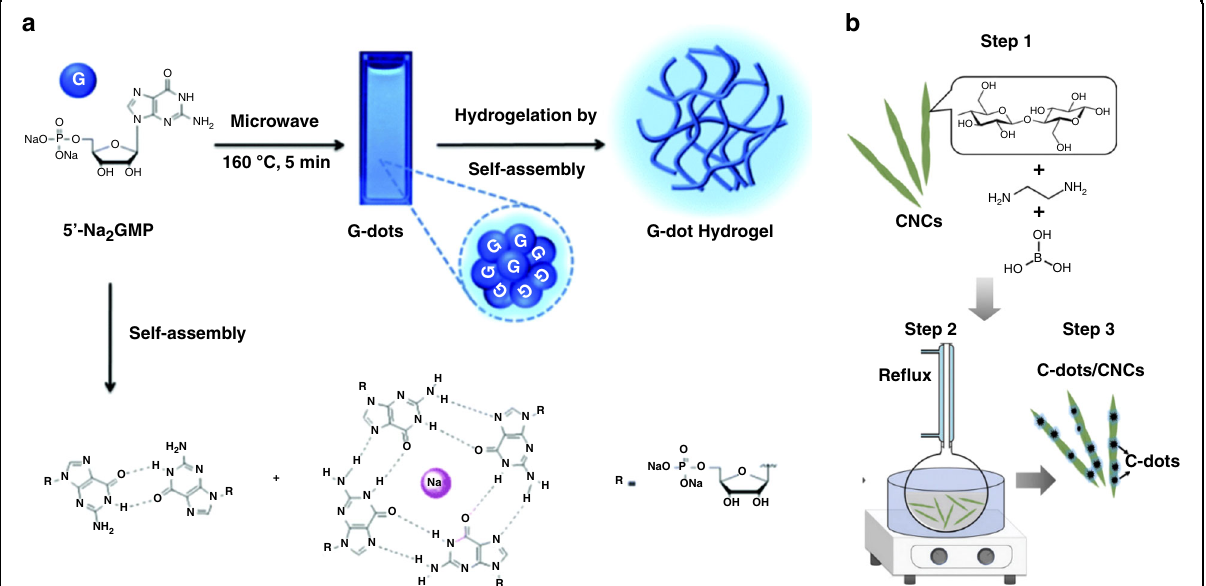
Fig. 4 Examples of chiral heterostructures with carbon dots. a Formation of guanosine 5 ’ -monophosphate (5 ′ -GMP) carbon dots and the carbon dots-based hydrogel; b synthesis of chiral carbon dots at the surface of cellulose nanocrystals. a Adapted with permission from 52 Copyright 2016 Royal Society of Chemistry. b Adapted with permission from 63 Copyright 2019 Wiley-VCH